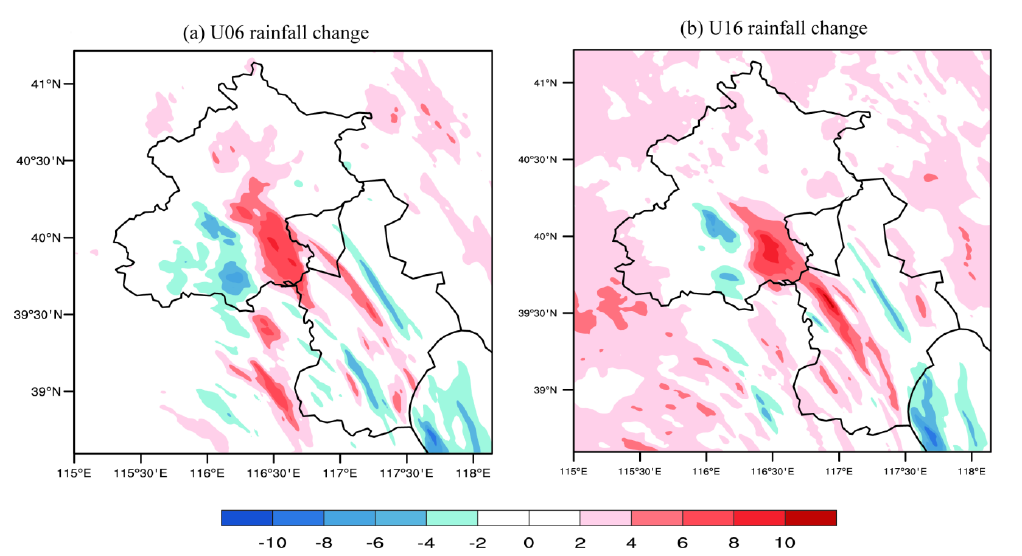
Figure 4. The average hourly rainfall changes from 18:00 UTC 19 July 2016 to 00:00 UTC 21 July 2016 relative to ( a ) Urban06 test and No urban test; ( b ) difference between the Urban16 test and No urban test (units: mm).